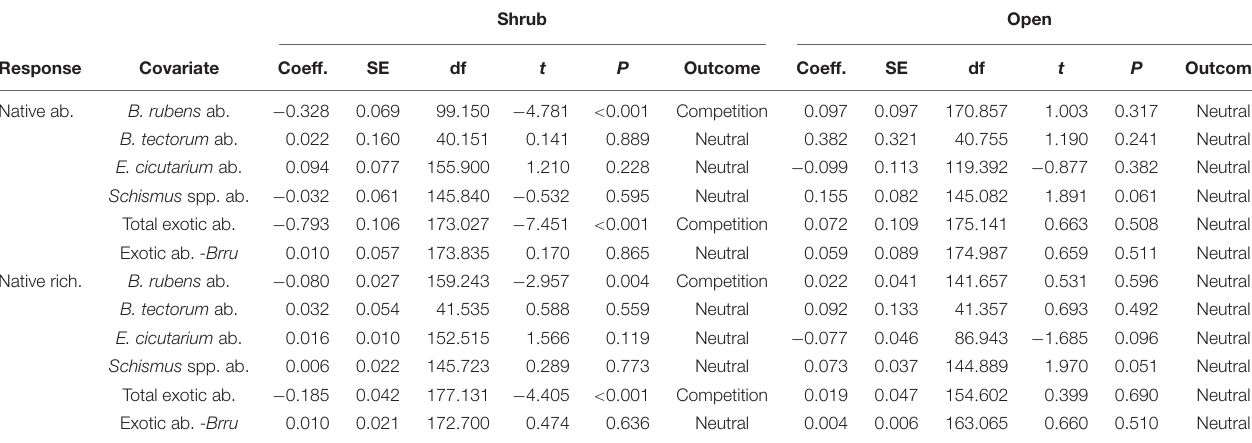
TABLE 2 | Results of linear mixed-effects models replicated for shrub and open microsites with native abundance or native species richness (all native species combined) as the response variable; abundance of B. rubens , B. tectorum , E. cicutarium , Schismus spp., all exotic species combined (Total exotic ab.), or exotic species except for B. rubens (Exotic ab. - Brru ) as the covariate; and shrub species nested within study site as a random effect (not shown). Shrub Open Response Covariate Coeff. P Outcome Coeff. P Outcome